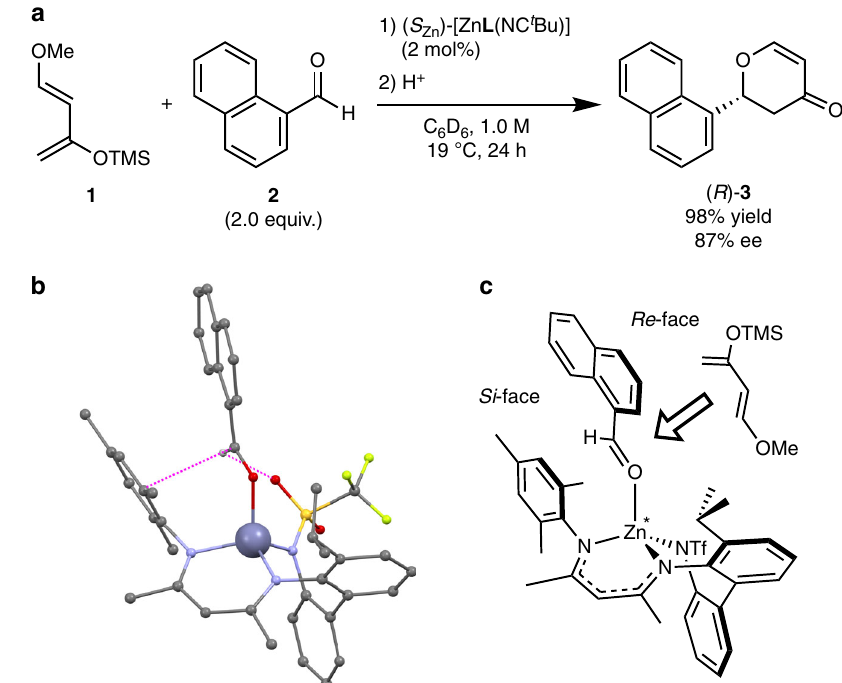
Fig. 6 Asymmetric oxa-Diels – Alder reaction with an ( S Zn )-[ZnL(NC t Bu)] catalyst. a Reaction scheme. equiv. equivalents, ee enantiomer excess. b Single- crystal X-ray structure of rac -[Zn L ( 2 )] (only the R Zn form is shown here) in a ball-and-stick model. Hydrogen atoms except in the formyl group are omitted for clarity. Colour code: Zn, blue grey; C, grey; N, blue; O, red; F, yellow green; S, yellow. Dashed magenta lines denote suggested noncovalent interactions (a hydrogen bond and a π – π interaction). c A schematic representation of a plausible origin of the